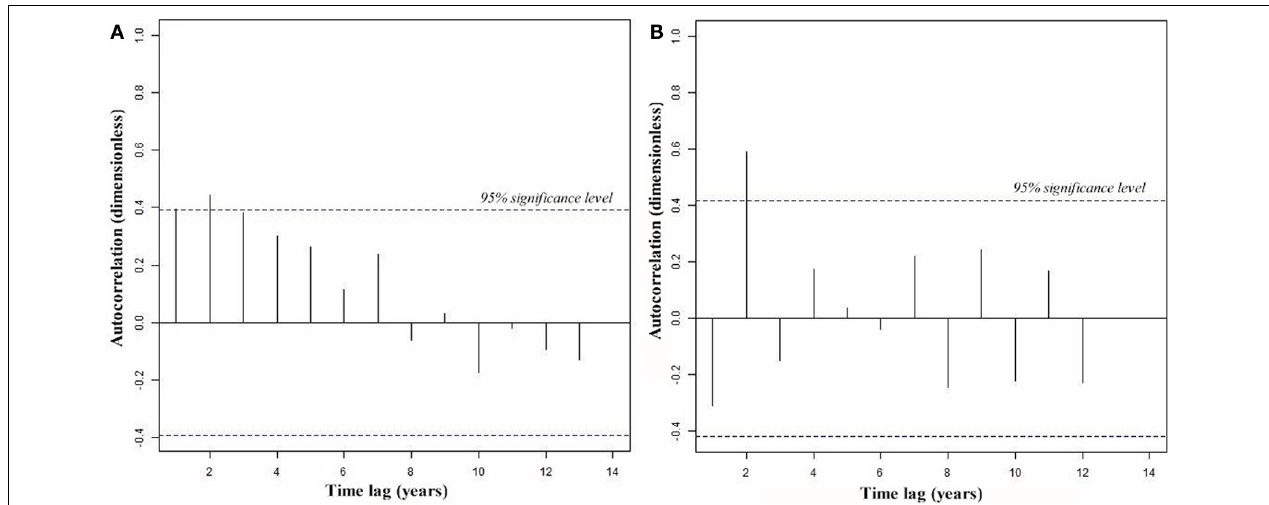
FIGURE 9 | Identified patterns of autocorrelation functions (ACFs) of historical crop yield for CARs with high RMSE forecast error. (A) CAR 4860 with AR(3) process with positive slope, and (B) CAR 4610 with AR(1) process with negative slope.